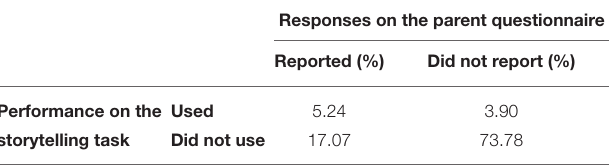
TABLE 4 | Relationships among how frequently parents talk about emotions with their child. Sad Happy Angry Scared Guilty